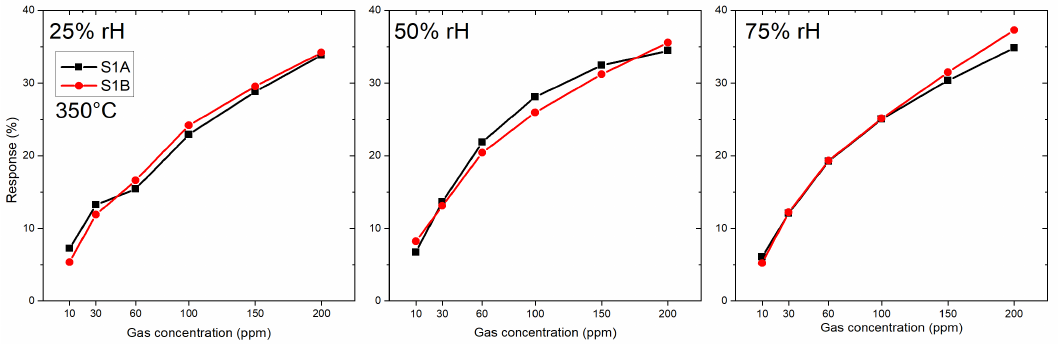
Figure 7. Response of SnO 2 nanowires-based membrane sensors towards CO at 350 ◦ C: 1A and 1B — both of them prepared by the same technology.